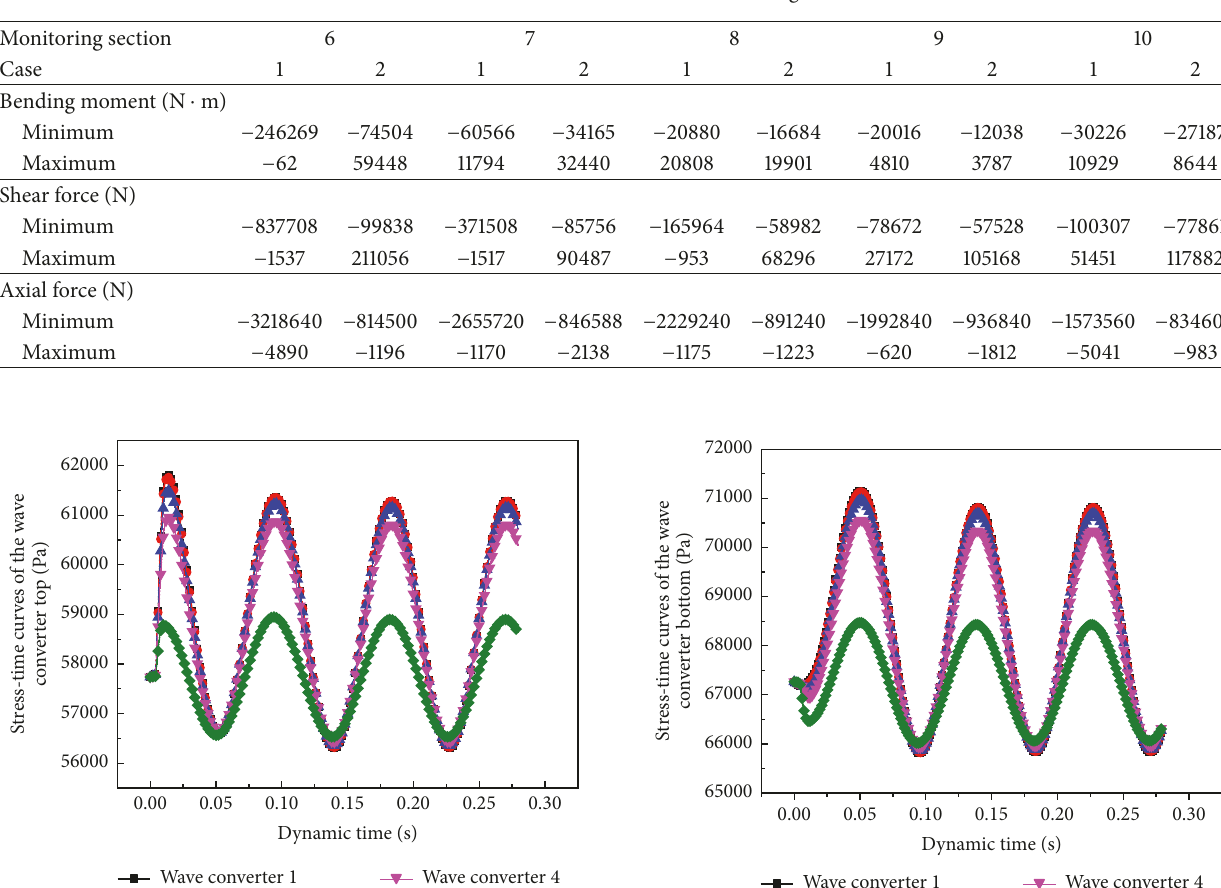
Table 5: Internal forces of the structure for monitoring sections 6–10.